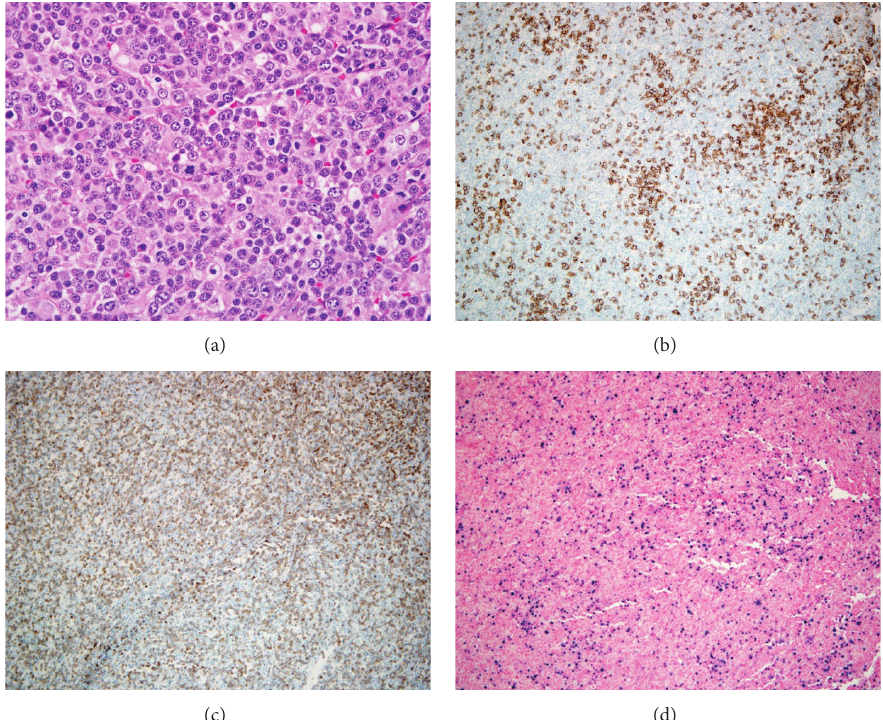
Figure 1: (a) The lymph node is effaced by an infiltrate of lymphocytes with range of cytologic features ranging from large lymphocytes with prominentnucleolitosmallerlymphocytesandplasmacells(hematoxylinandeosin,400xamplification).(b)Paraffinimmunohistochemistry using antibodies against CD20 highlights B-cells with focal loose clusters (CD20, 100x magnification). (c) Small CD3 positive T cells are present in the background (CD3, 100x magnification). (d) Chromogenic in situ hybridization using probes to detect Epstein-Barr virus encoded RNA shows numerous EBV positive cells within the infiltrate, with many more EBV positive cells than would be expected in a lymph node with latent EBV infection (EBV-ISH, 100x